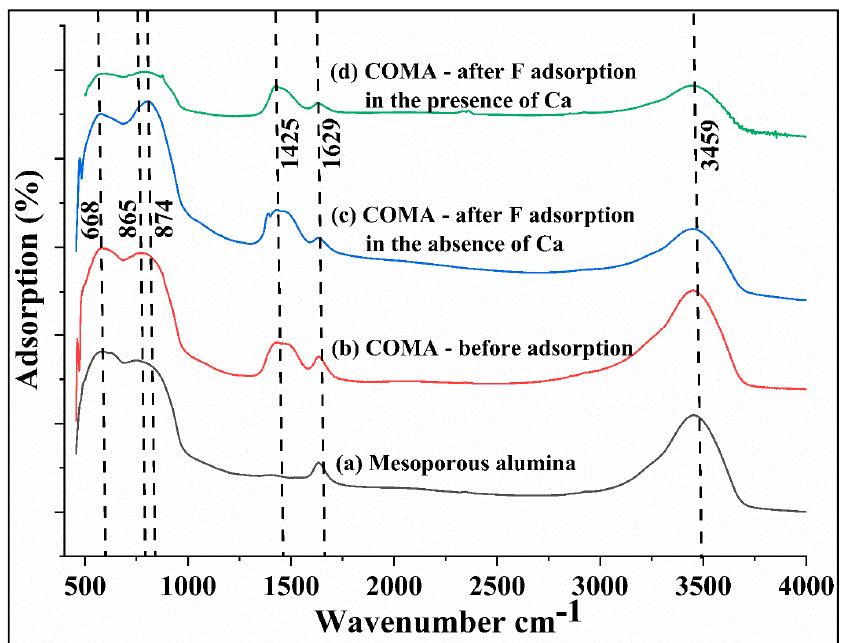
Figure 3. FT-IR spectra of mesoporous alumina and COMA.